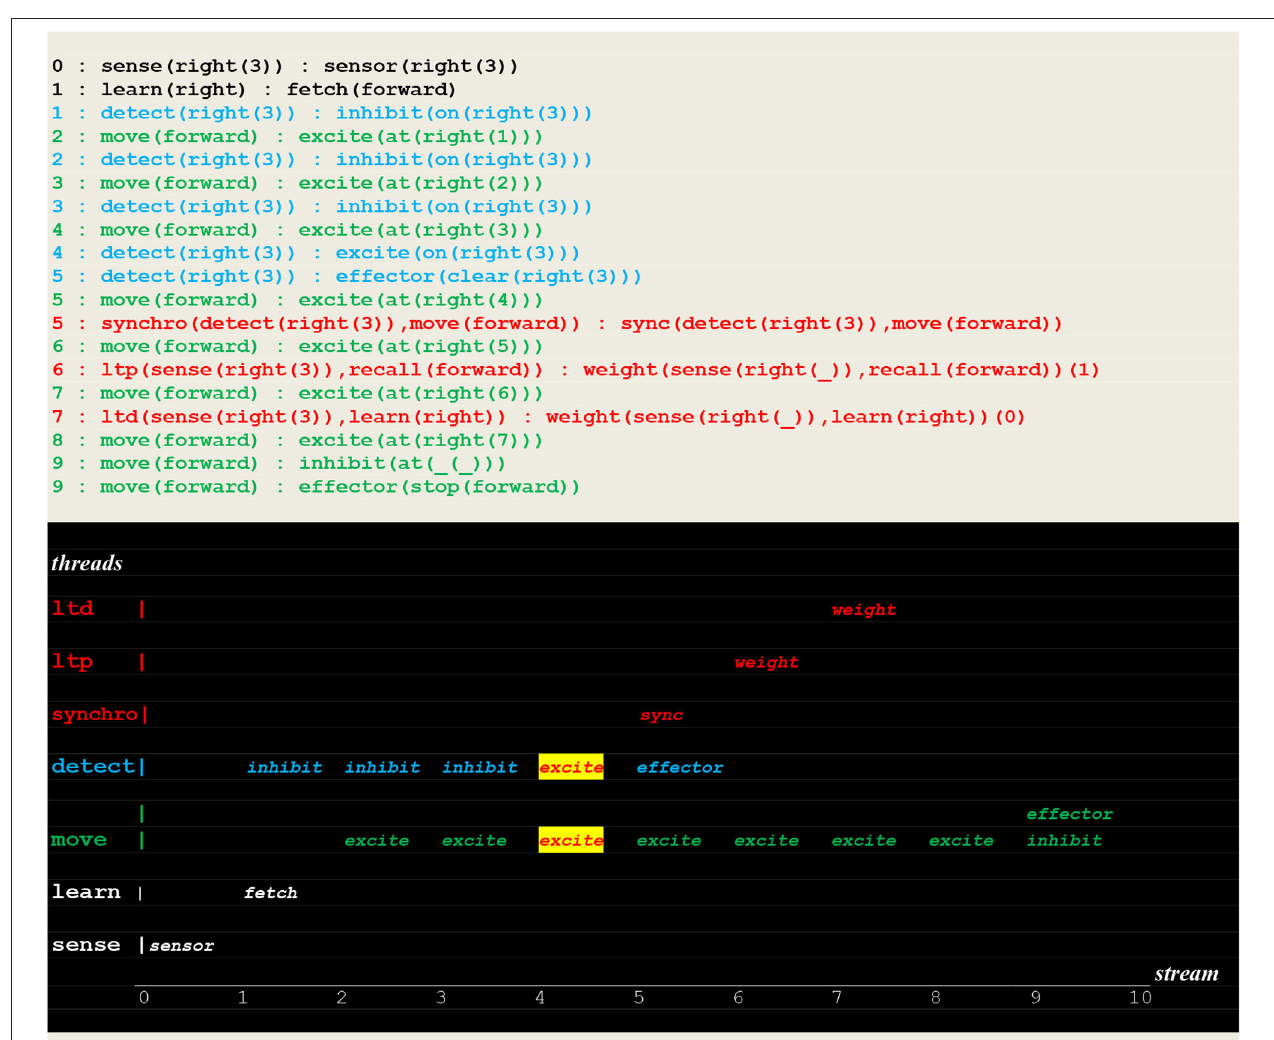
FIGURE 17 | Execution trace of learning a non instantiated rule. This run is similar to the one presented in Figure 14 , with the only difference being the weight changes applied to non instantiated links i.e., ( sense(right(_)),recall(forward)) and ( sense(right(_)),learn(right))